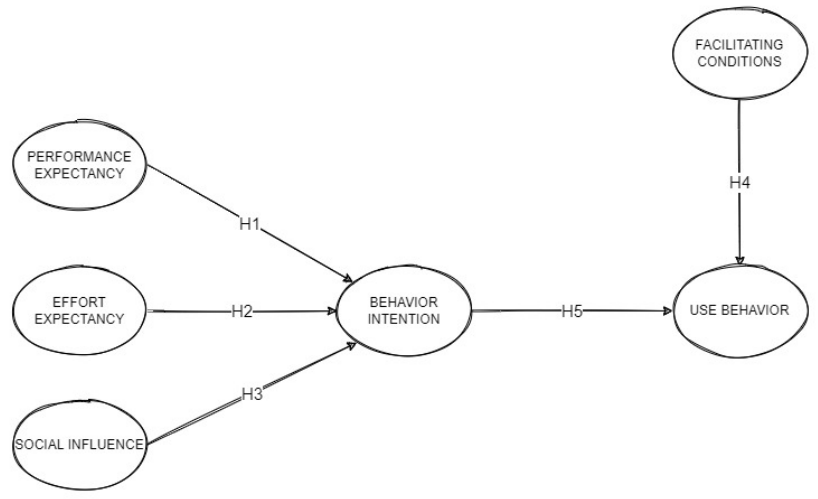
Figure 1. Conceptualized UTAUT